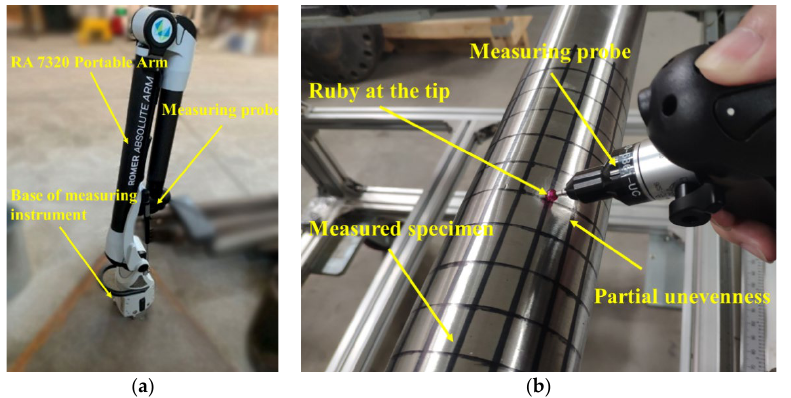
Figure 2. ( a ) RA 7320 Portable Arm Coordinate Measuring Machine. ( b ) Photos of geometric characteristics measuring.